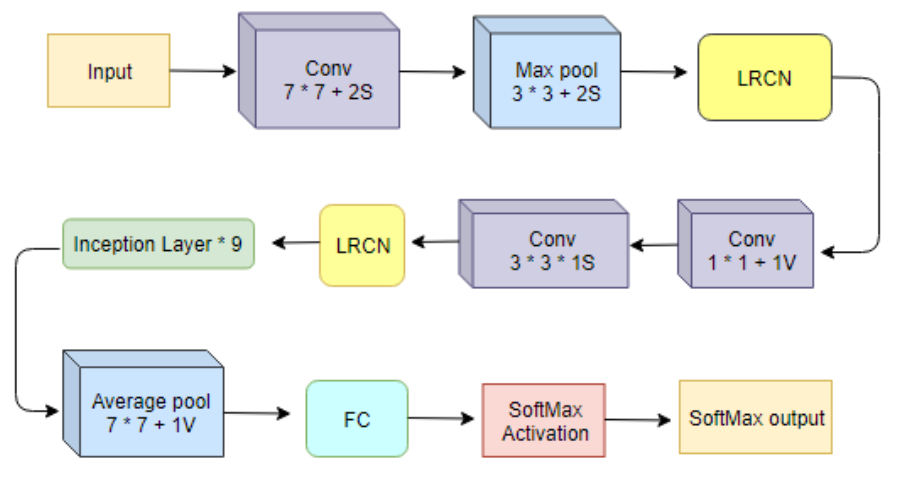
Figure 10. GoogleNet architecture.